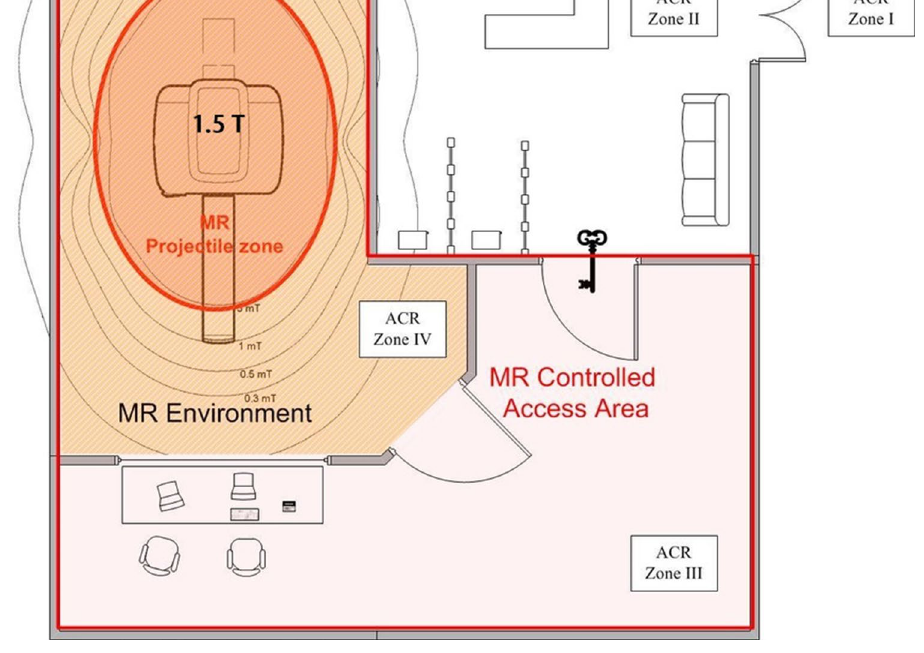
Fig. 2 3.0 T MRI unit